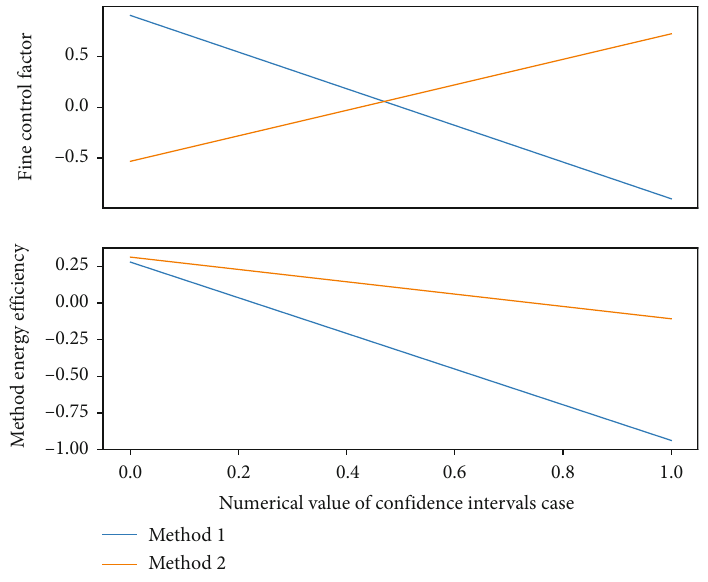
Figure 2: Con fi dence interval of fi ne control energy e ffi